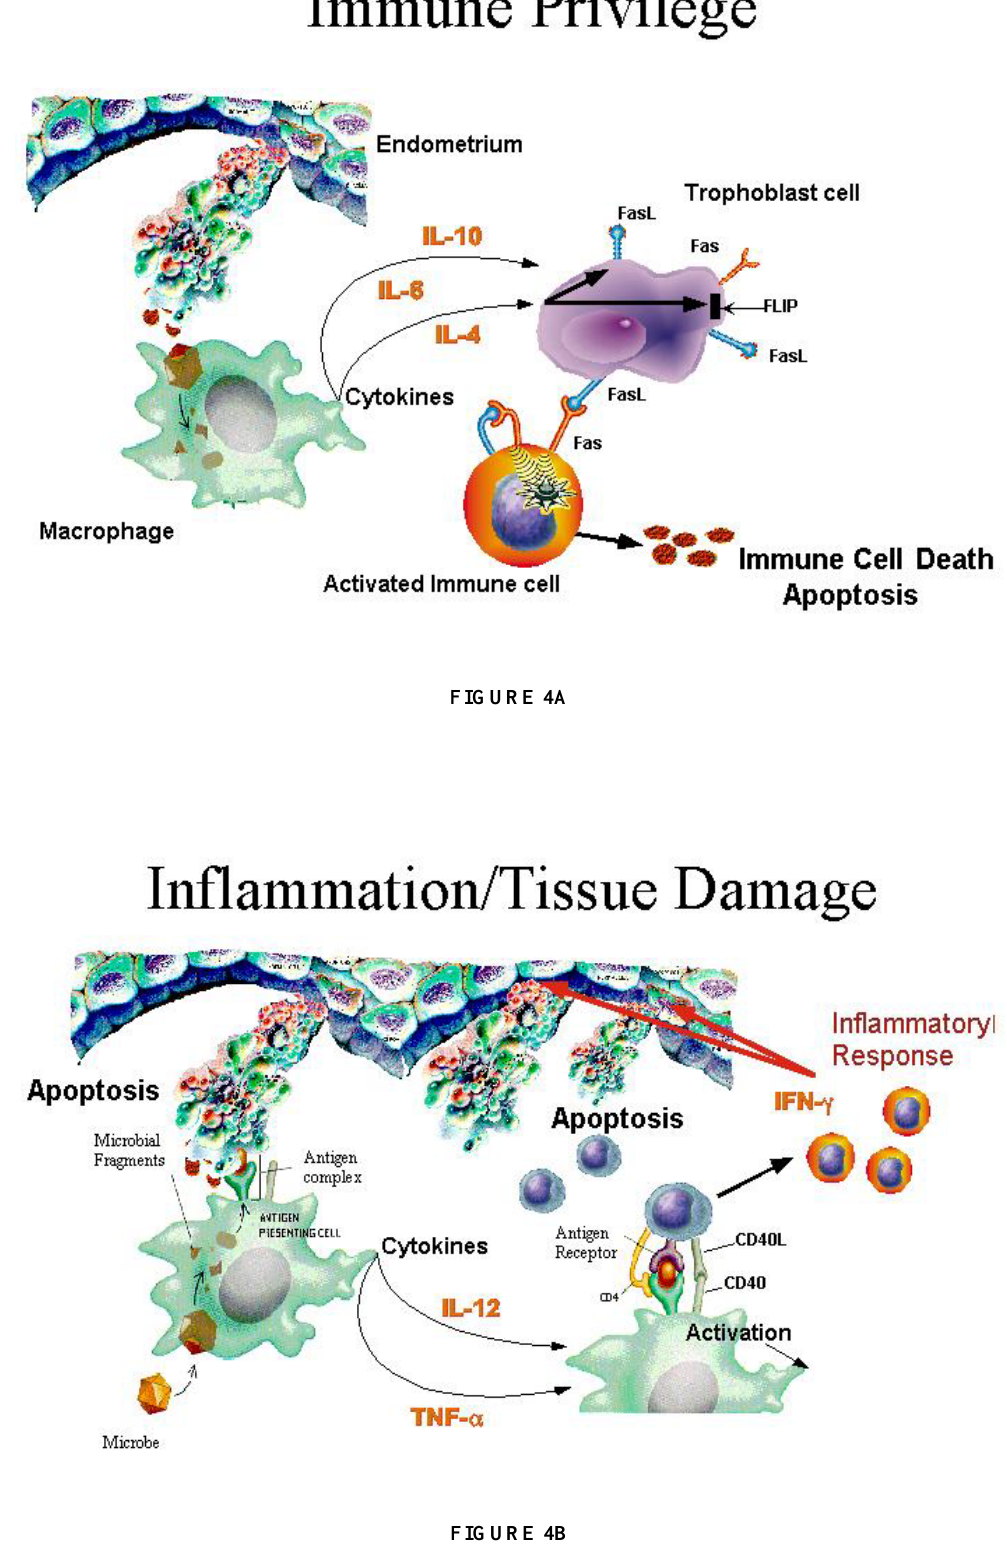
FIGURE 4 . Immune Privilege. A. Trophoblast cells induce apoptosis of activated immune cells through the expression of FasL on its surface. FasL expression is supported by locally produced anti-inflammatory cytokines. B. Bacterial infection or excessive apoptosis activates macrophages towards a proinflammatory cytokine profile. The inflammatory response further induces cell apoptosis and tissue